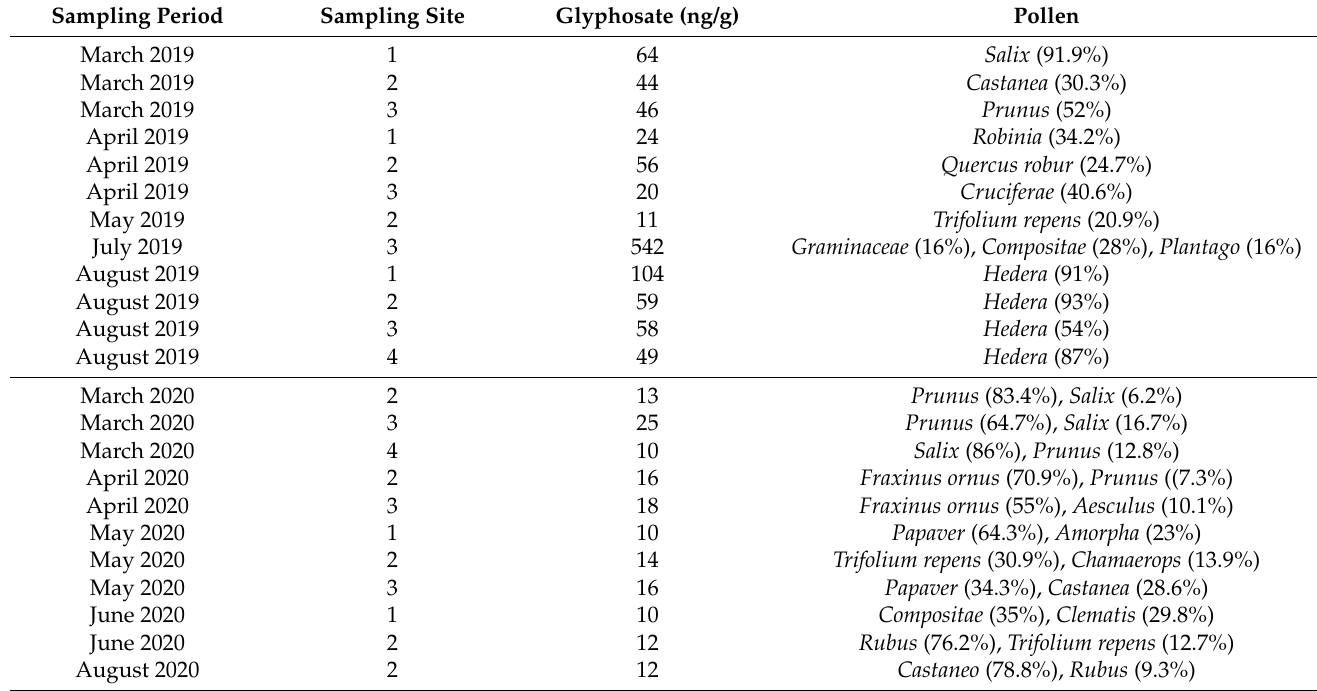
Table 4. Palynological